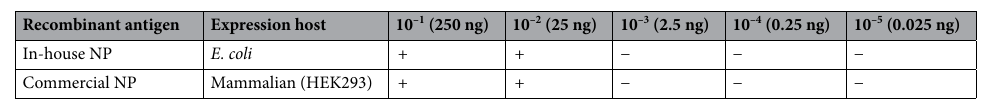
Table 1. Comparative evaluation with commercial CCHF antigen and in-house recombinant